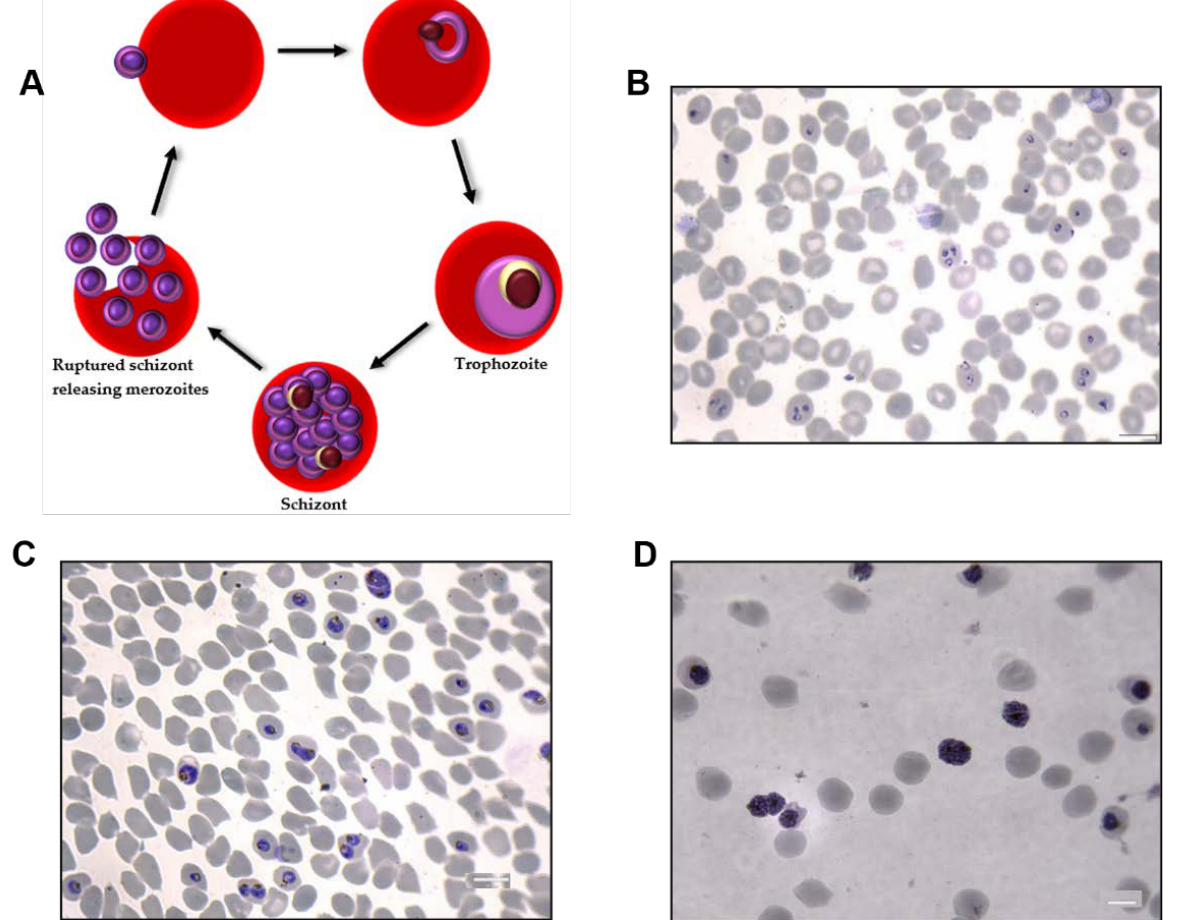
Figure 1. ( A ) The intraerythrocytic life cycle of malaria parasites. Ring, trophozoite and schizont stages last for approximately 24, 14 and 10 h, respectively. Parasite cultures were kept tightly syn- chronized to contain ≥85 % of a specific blood stage. Conditioned culture media was harvested from cultures at 22-, 38- and 46-h post-invasion, to ensure the EVs present were released from ( B ), ring-, ( C ) trophozoite- or ( D ) schizont-iRBCs. Scale bar–10 μm. The 3D7 strain of P. falciparum was grown in fresh human A + RBCs (up to 14 days old) in RPMI 1640 supplemented with 0.5% Albumax I, 10mM hypoxanthine, 1M NaOH and 50mg/mL gentamicin. Cultures were incubated at 37 °C with atmospheric conditions